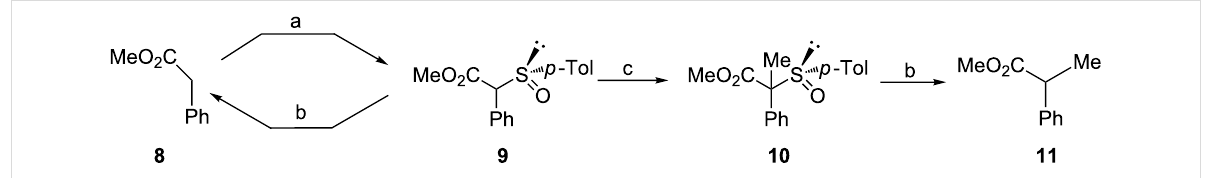
Scheme 3: Reaction of acyclic sulfoxides with phenylsilane. Reagents and conditions: (a) BuLi, THF, − 70 °C, p -TolS(O)Men; (b) PhSiH 3 , THF, rt, KOH (5 mol %); (c) MeI, 50% KOH, CH 2 Cl 2